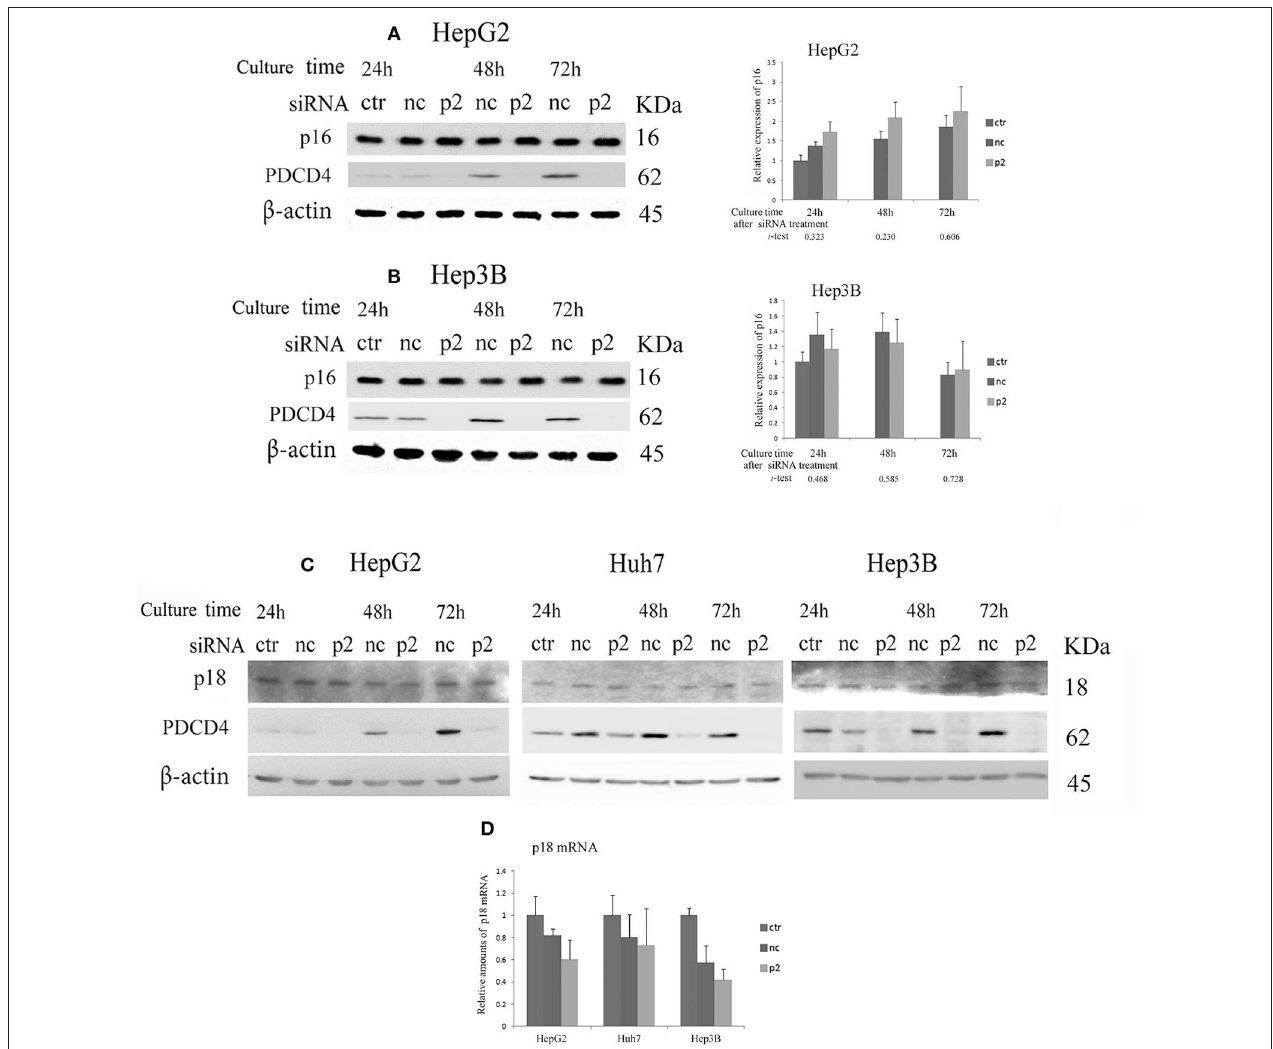
FIGURE 5 | The expression of the INK4 inhibitors p16 and p18 in PDCD4 knockdown cells. Cells were treated with negative control siRNA (nc) or PDCD4-specific p2 siRNA (p2) and subjected to a Western blotting analysis with p16-, p18-, PDCD4-, and β -actin-specific antibodies after culturing for the times indicated in the figures. (A,B) A Western blot analysis (Left) and diagrams of the relative p16 expression (Right) obtained from the Western blot in (A) HepG2 and (B) Hep3B cells. The experiments were repeated independently three times. The data in the diagrams represent the mean ± SD obtained from the three experiments. ( t -test: p -values determined by Student’s t -test from the p16 amounts in p2 and nc). The p -values show that the difference in the p16 expression between PDCD4 knockdown cells and negative control cells was not significant. (C) The p18 levels were not markedly changed by PDCD4 knockdown in HepG2, Huh7, and Hep3B cells. These experiments were repeated at least three times, and similar results were obtained each time. ctr, control cells without treatment with siRNAs; nc, negative control siRNA-treated cells; and p2, PDCD4-specific p2 siRNA-treated cells. (D) A real time RT-PCR analysis of p18 in PDCD4 knockdown HepG2, Huh7, and Hep3B cells. The cells were treated with negative control siRNA (nc) or PDCD4-specific p2 siRNA (p2) and cultured for 48h. The experiments were repeated independently 3 times.